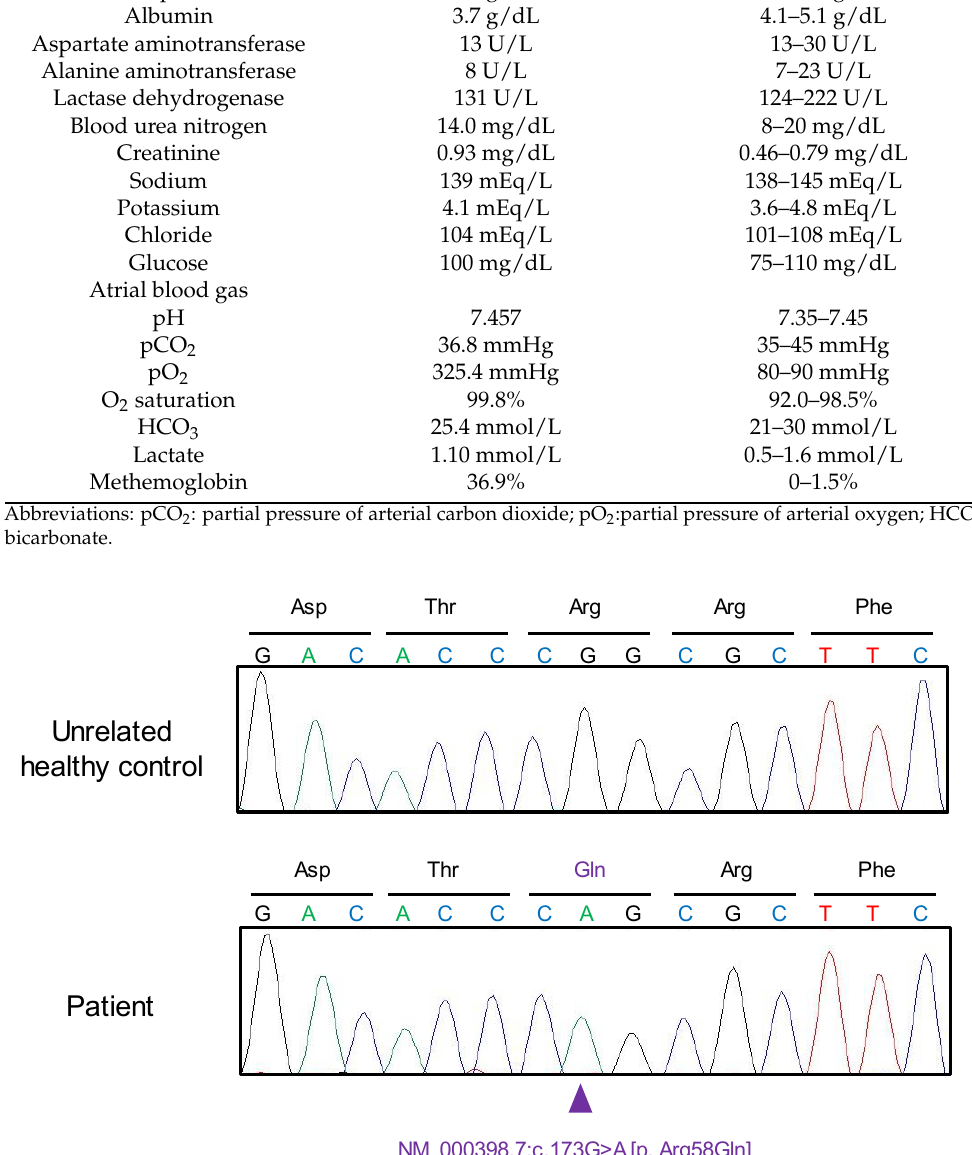
Figure 1. Electropherogram of the region of the variant NM_000398.7:c.173G>A [p.Arg58Gln]. The location of the variant is shown using a purple arrowhead. Abbreviations: Asp: Aspartic Acid; Thr: Phenylalanine; Arg: Arginine; Phe: Phenylalanine; Gln: Glutamine.